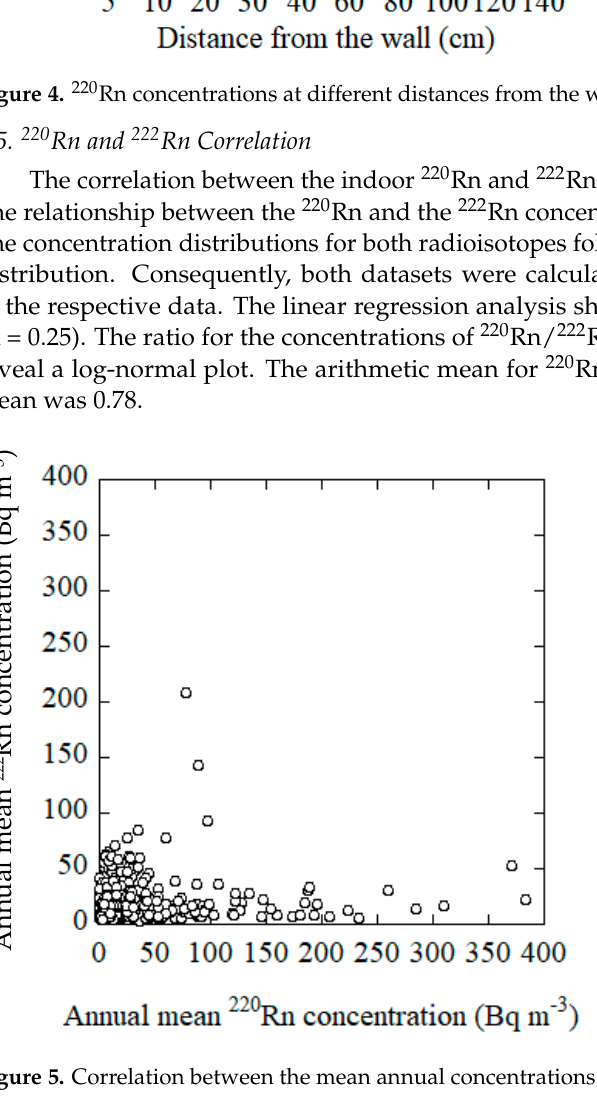
Figure 5. Correlation between the mean annual concentrations of 220 Rn and 222 Rn.